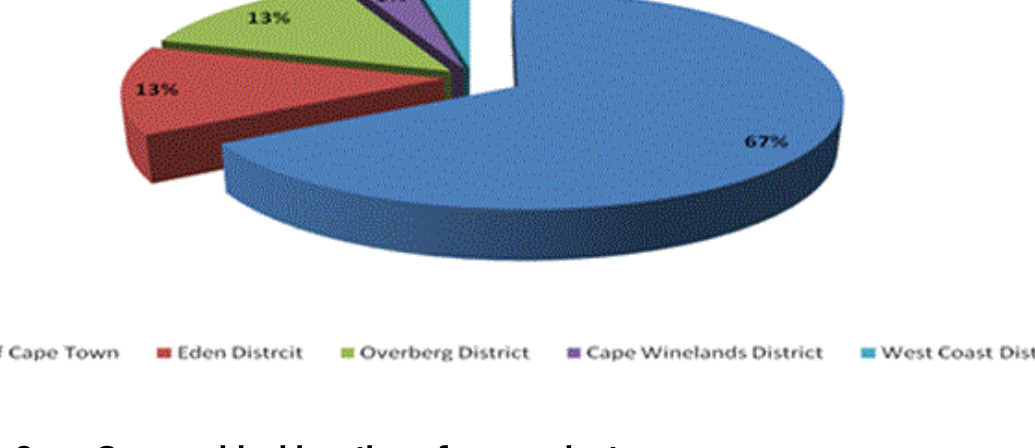
Figure 8: Geographical location of